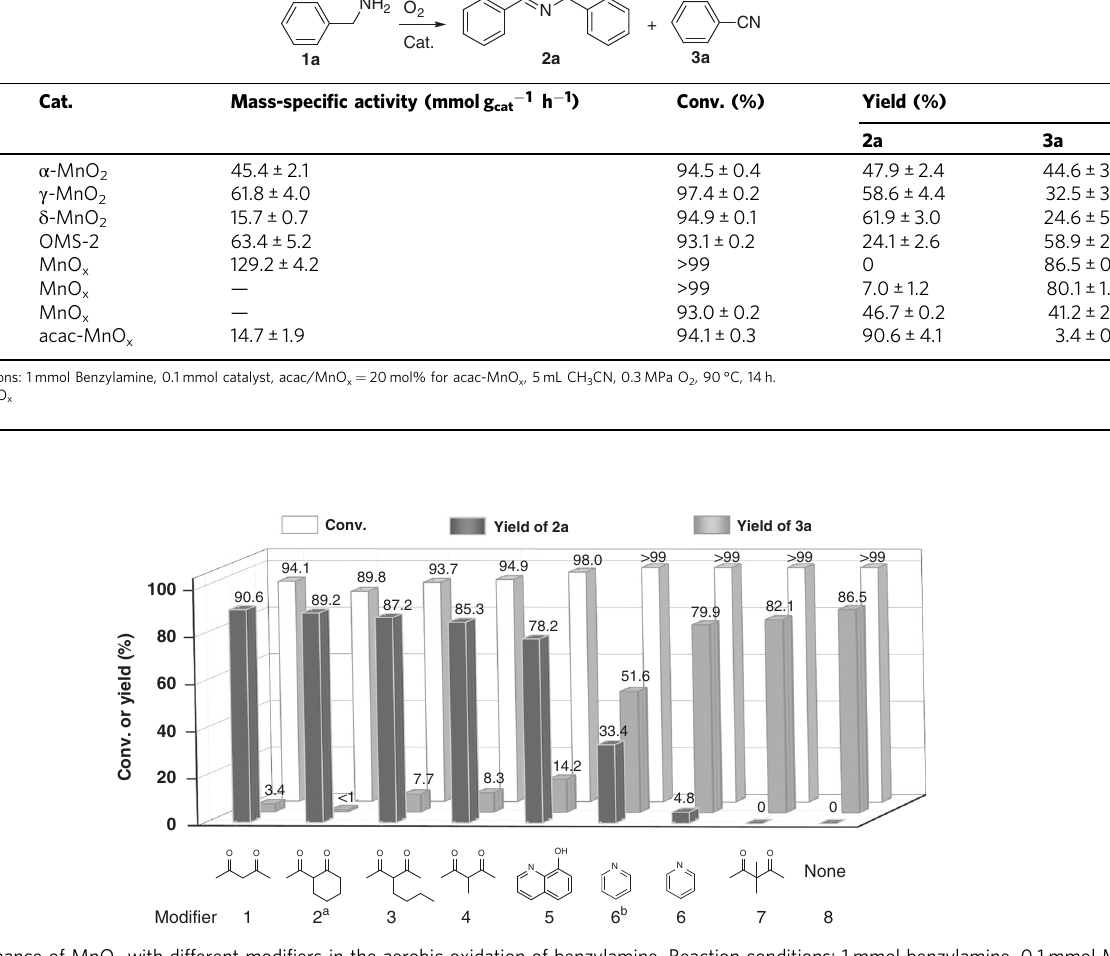
Table 1 The catalytic performance of manganese oxide catalysts in the benzylamine aerobic oxidation reaction Cat.O